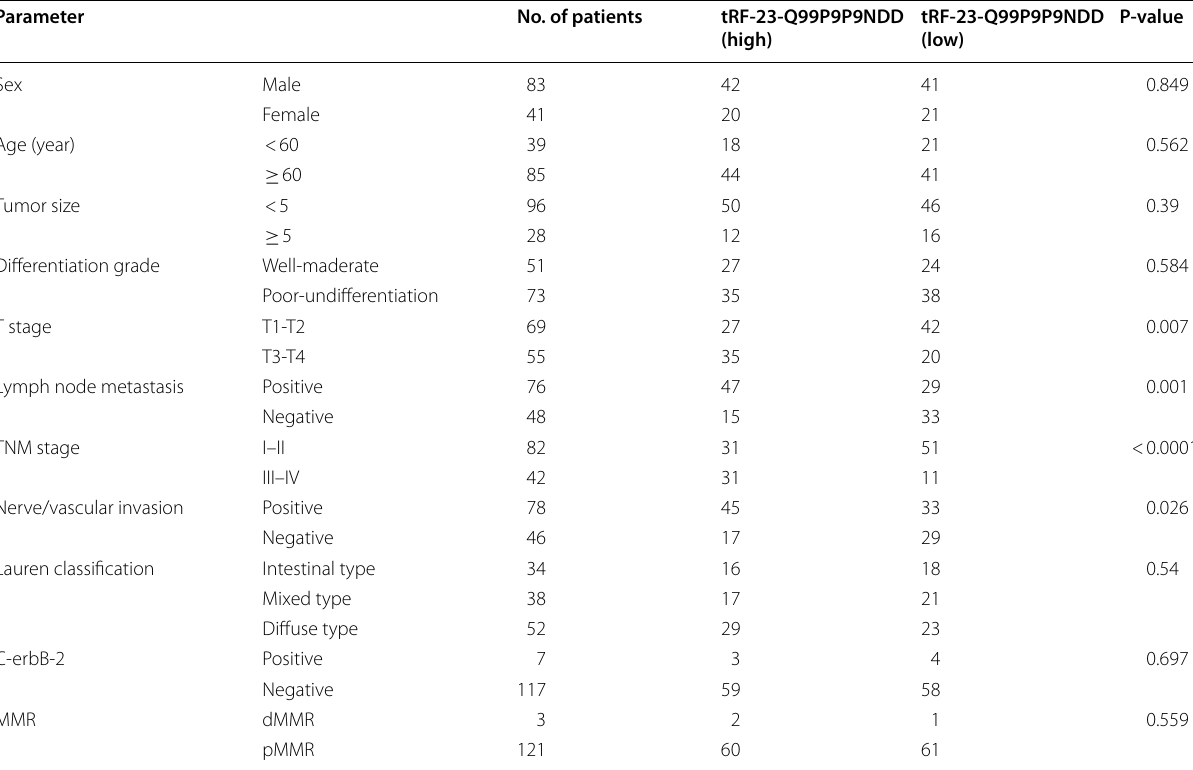
Table 2 Clinicopathological analysis of